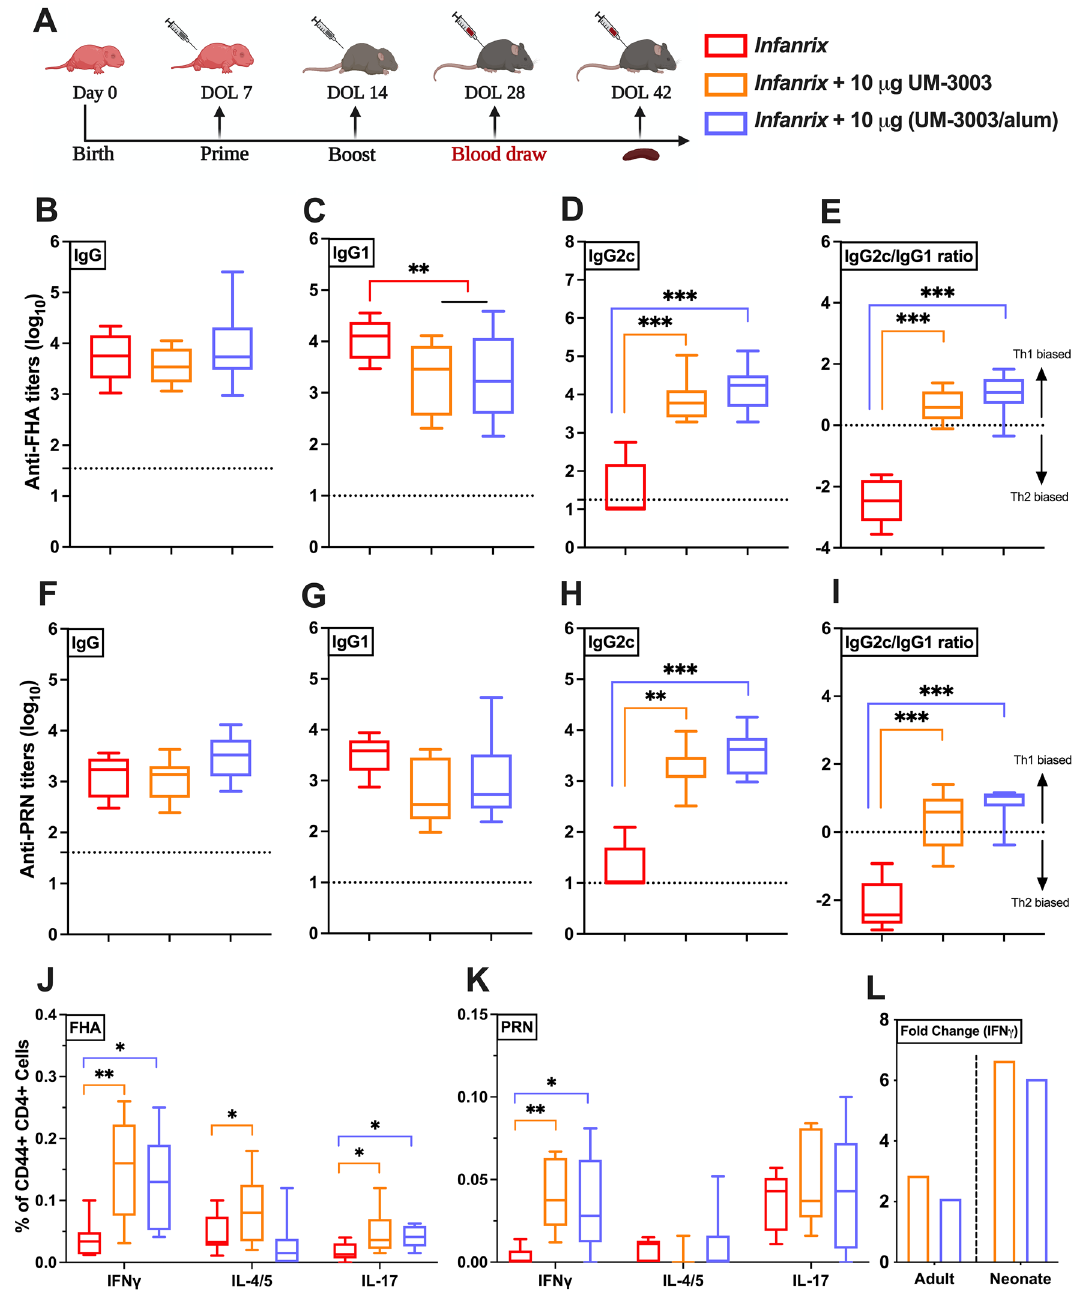
Figure 6. UM-3003 enhances DTaP specific IgG2c production and Th1/Th17 polarization in neonatal mice. ( A ) 7 days old C57BL/6 were vaccinated (prime/ boost) with DTaP (1/100th of the human dose) ± UM-3003 or UM-3003 at 10 µg per mouse in alum absorbed formulations. Serum was harvested 14 days following boost (DOL 28). Anti-FHA ( B – E ) and anti-PRN ( F – I ) serum total IgG ( B , F ) titers, IgG1 ( C , G ) and IgG2c ( D , H ) were measured by ELISA. PBS control groups were represented as dotted line. ( E , I ) IgG2c/IgG1 ratios for FHA and PRN respectively. ( J , K ) Splenic CD4 + T cell responses after FHA and PRN stimulation. Four weeks following booster, splenocytes from vaccinates were isolated and stimulated with 2 μg/ml of either FHA or PRN along with CD28 (1 μg/ml) and CD49d (1 μg/ml) for 12 h followed by 6 h of BFA stimulation. After stimulation, cells were harvested and stained (intracellular cytokine staining) and analyzed by flow cytometry. Plots were gated on CD44 + CD4 + lymphocytes and analyzed for all combinations of simultaneous IFNγ, IL-4/5 and IL-17A productivity. ( L ) Fold change of FHA specific IFNγ production in splenic CD4 + T cell relative to DTaP are shown. Statistical comparison was performed either using one-way ANOVA (C, E) or nonparametric Kruskal– Wallis test corrected for multiple comparisons; * p < 0.033, ** p < 0.002, *** p < 0.001 (n = 9–13 per group), with comparison to DTaP alone. Study is inclusive of two independent